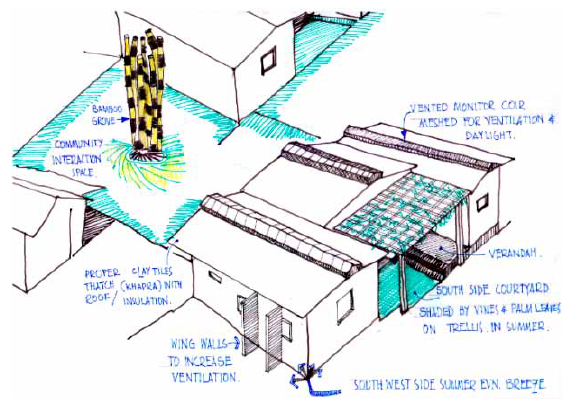
fig. 24. Clustering of u-shaped dwelling units for availing of southern side summer-time evening